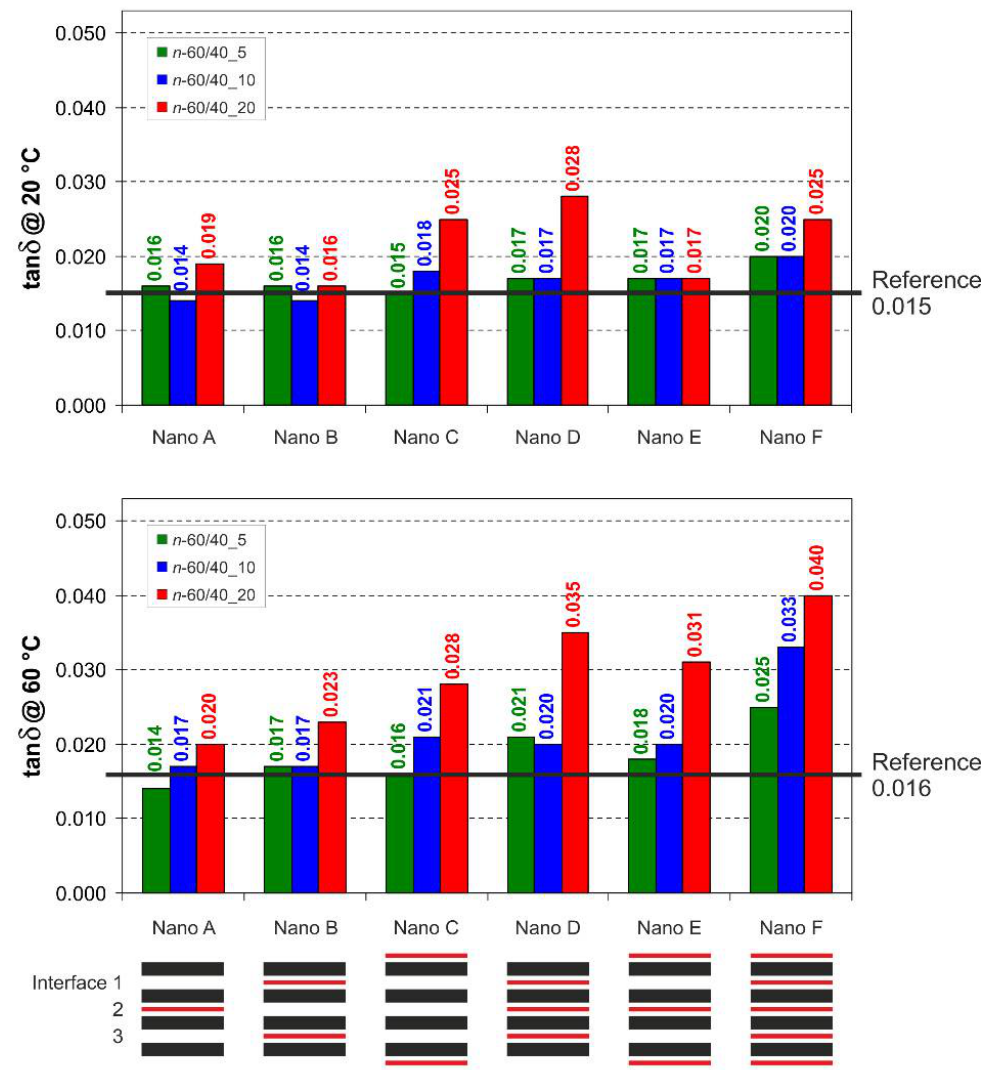
Figure 11. Tan δ and values at 20 and 60 ◦ C (standard deviations, not reported, are not higher than Figure 11. Tanδ and values at 20 and 60 °C (standard deviations, not reported, are not higher than 0.002 in all the cases). DMA shows a strong effect on tan δ behaviour when the highest mat thickness (40 µ m, n -60/40_20) is interleaved. By contrast, a 10 µ m mat thickness ( n -60/40_5) shows a slight impact on overall damping improvement, even when all the interfaces are nano-modified. Intermediate thickness (20 µ m, n -60/40_10) affects tan δ behaviour in between the two